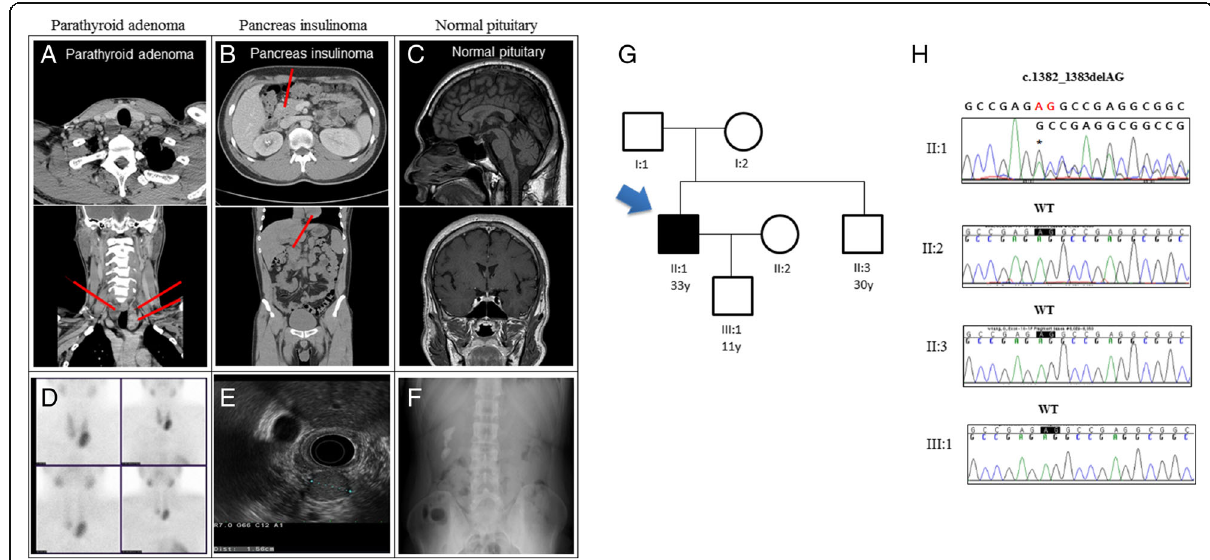
Fig. 1 Case subject. a Neck computed tomography (CT) scan: Heterogeneous enhancing mass with cystic changes in both paratracheal (right 1.5 cm, left 2.2 cm) and parathyroid adenomas. b Abdominal CT: About a 1.6-cm well-defined enhancing mass at the head of the pancreas; R/O endocrine tumor. c Sellar magnetic resonance imaging: Normal pituitary. d Sestamibi parathyroid scan: Multiple parathyroid adenoma. e Endoscopic